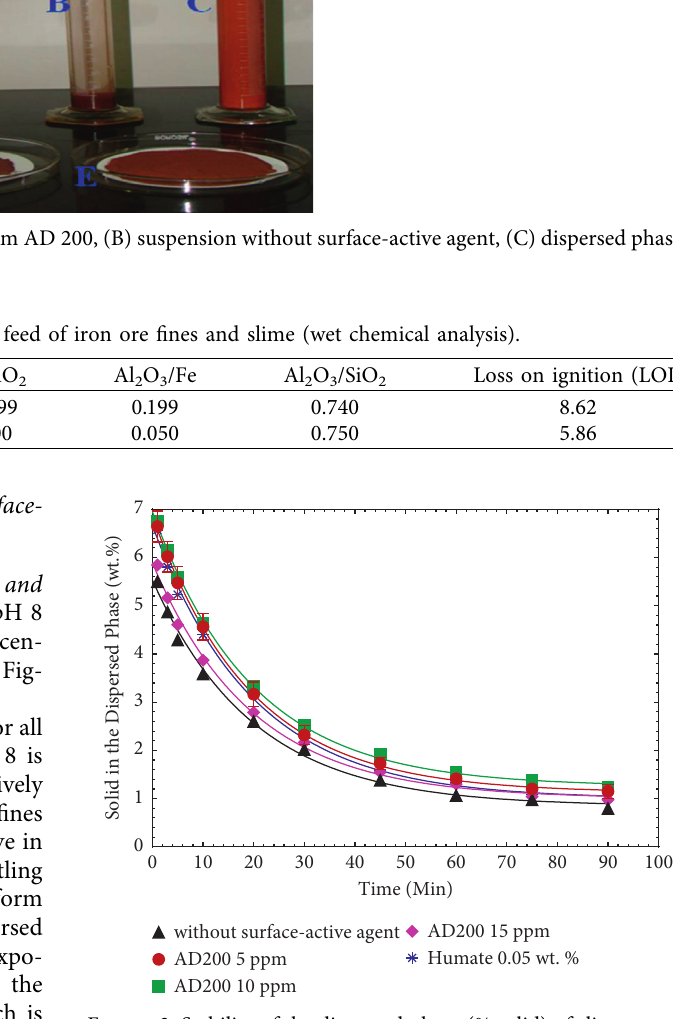
Figure 2: Stability of the dispersed phase (% solid) of slime versus time at pH 8 with different concentrations of AD 200 and humate and without surface-active agent. Data points represent minimum duplicate experiment. The solid lines represent equation (1).